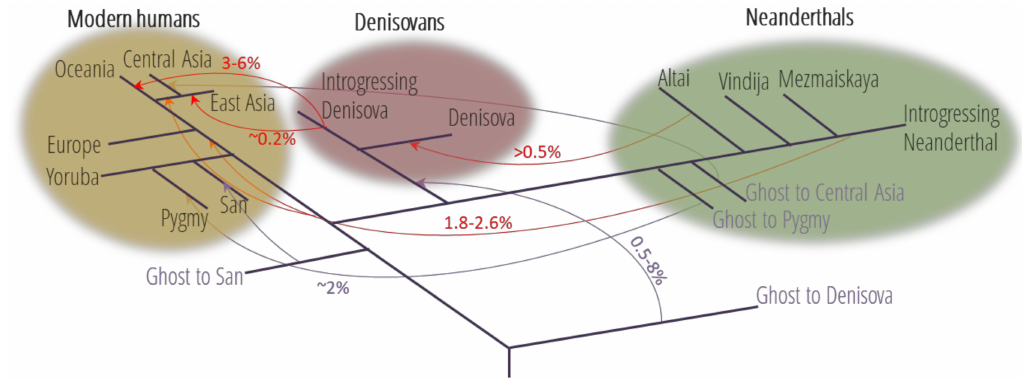
Figure 1. Family tree of the four groups of early humans living in Eurasia 50,000 years ago and the inferred gene flow between the groups due to interbreeding (based on [12–16]). The direction and estimated magnitude of inferred gene flow events are shown. Branch lengths and timing of gene flows are not scaled. Light violet color indicates introgression events from unknown archaic populations